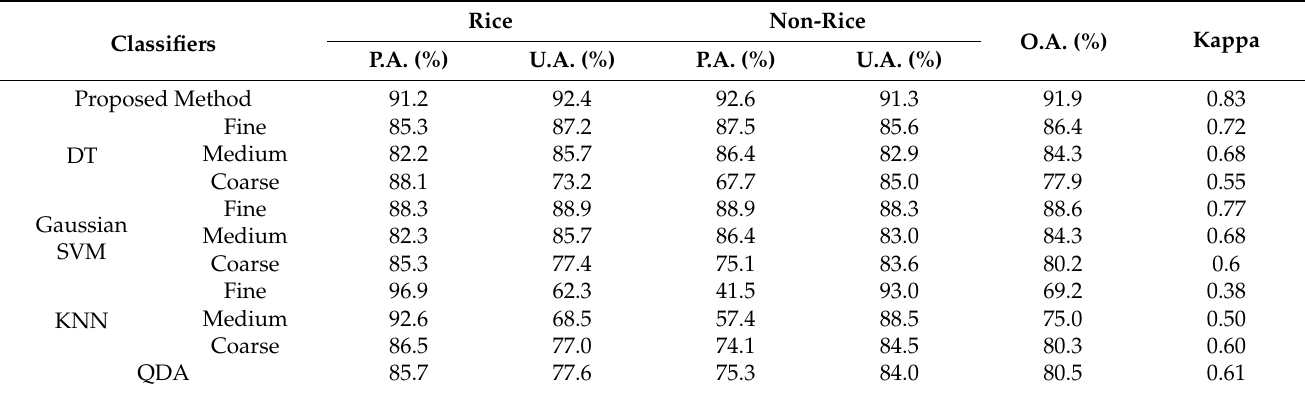
Table 6. Comparison of the proposed method with the other four classifiers for VH polarization with ascending orbit mode, including O.A., U.A., P.A. and kappa.